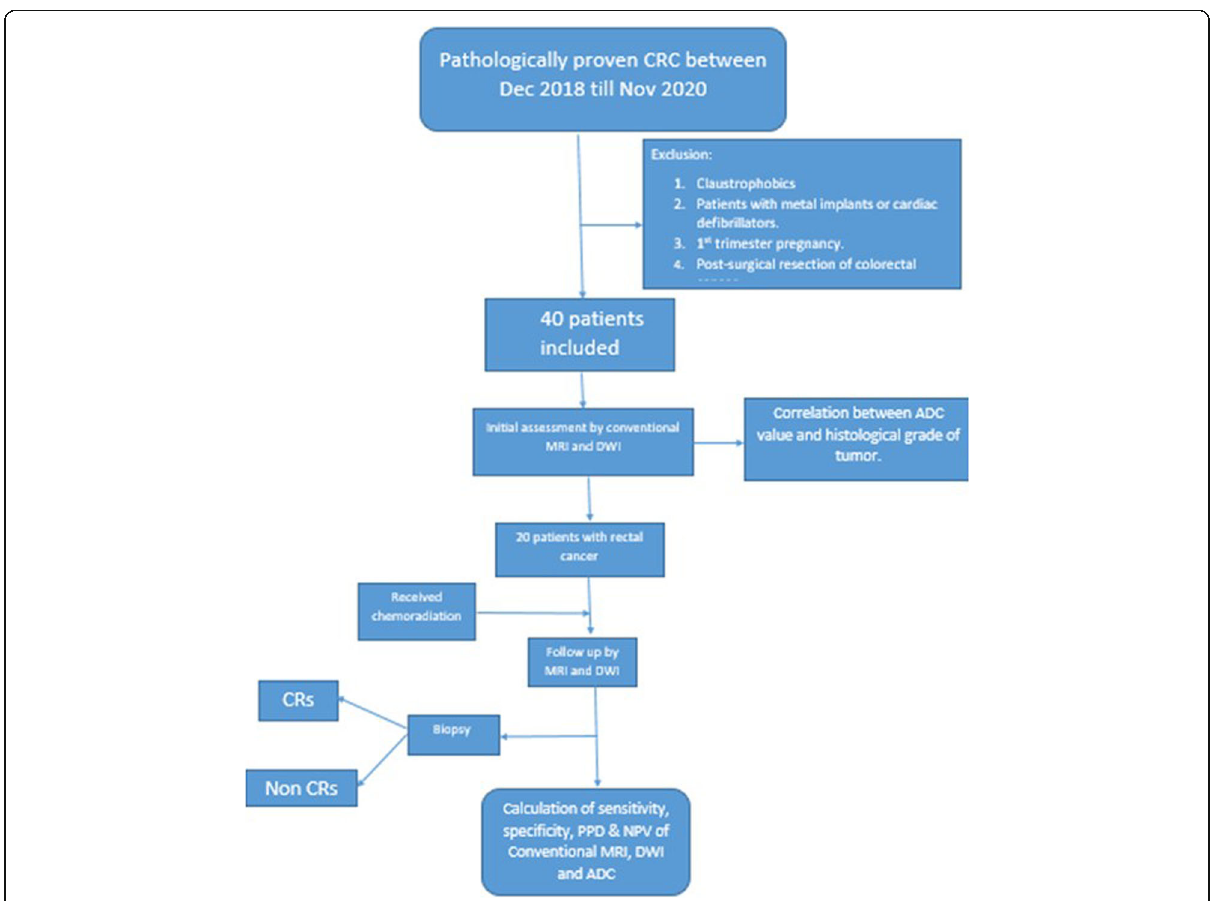
Fig. 1 Flow chart representation of the research